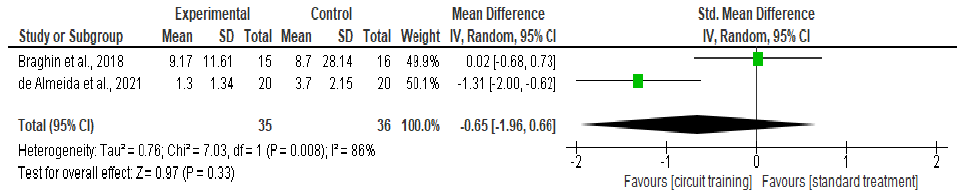
Figure 7. Forest plot analysis of the effect of CT on knee stiffness [33,39].